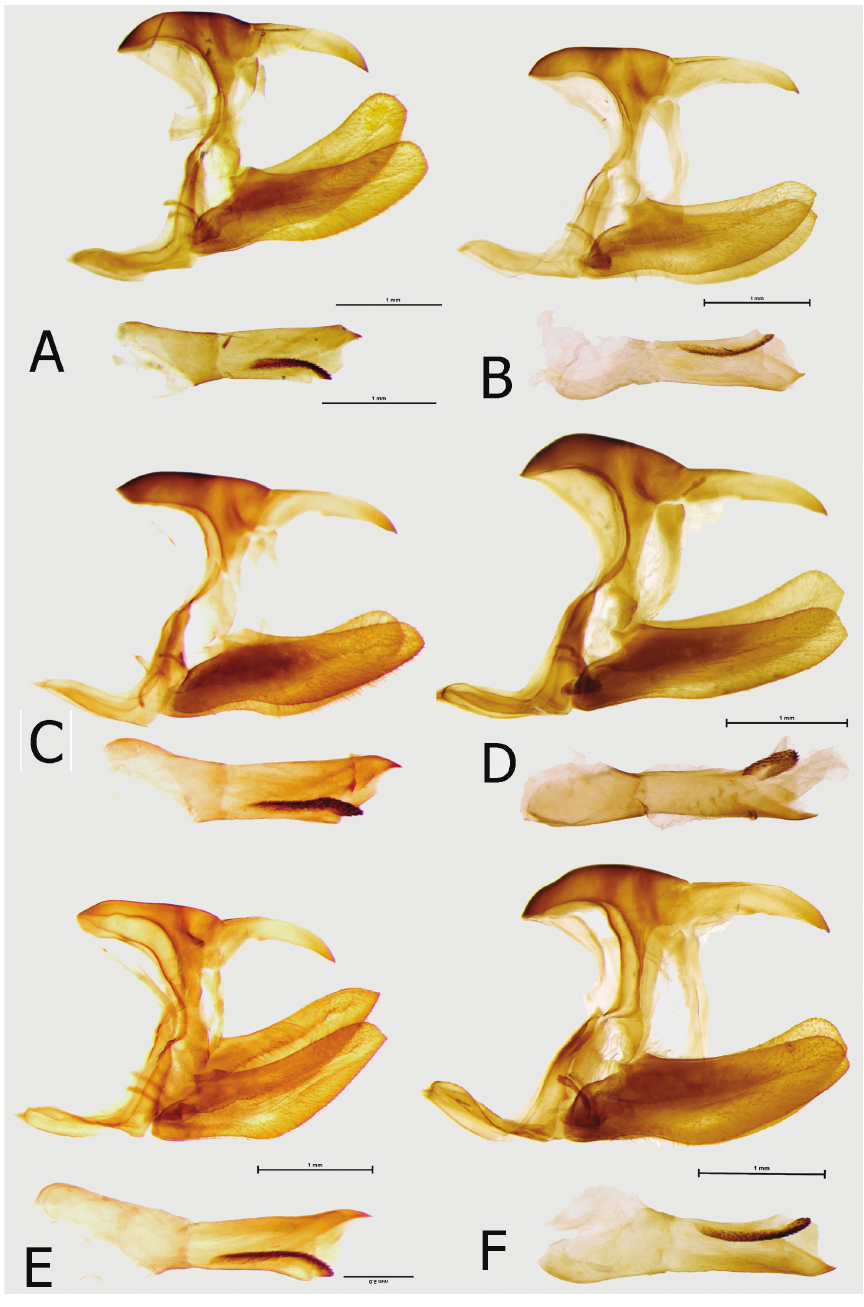
Figure 11. Male genitalia (in lateral view, aedeagus extracted): A E. sarcoptera sarcoptera Bibiani, Ghana B E. sarcoptera nipponicorum Mbandaka, Congo C E. sarcoptera styx Tai, Ivory Coast D E.